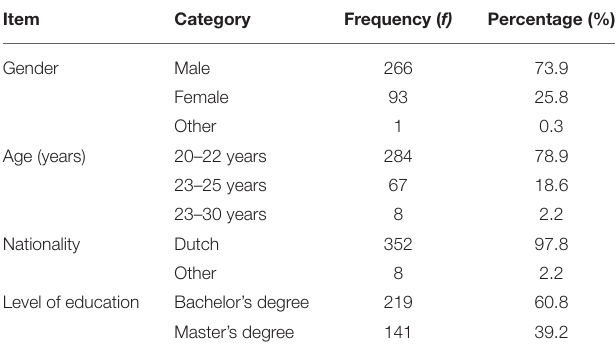
TABLE 1 | Demographic characteristics of participants ( n =